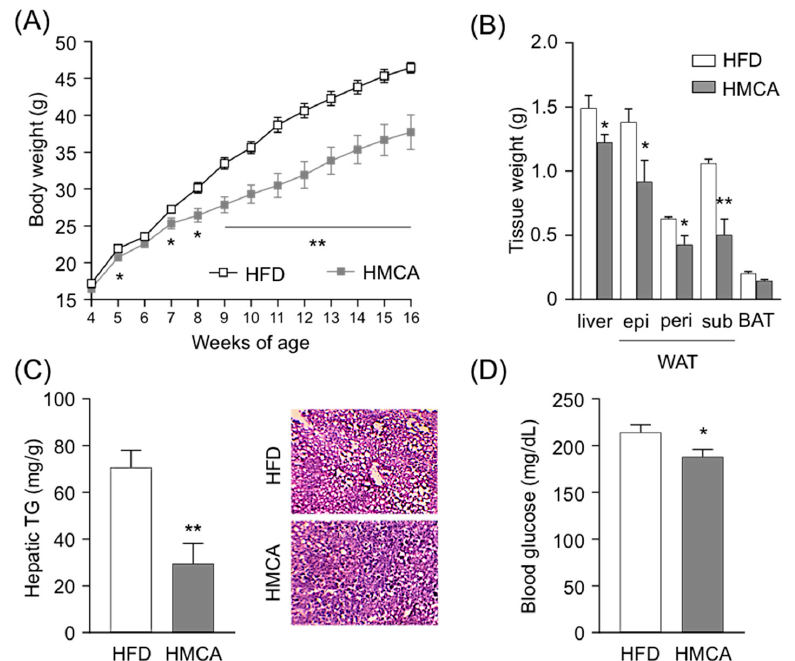
Figure 1. Metabolic parameters and histological changes in high-fat diet (HFD)- and 4-hydroxy-3-methoxycinnamic acid (HMCA)-supplemented HFD-fed mice. Mice were characterized for body weight gain ( A ), the mass of WAT, BAT, and liver ( B ), hepatic TG and histology of hepatocytes by hematoxylin and eosin (H&E) staining ( C ), and blood glucose ( D ) ( n = 7–8). All data are presented as the means ± SEM. Differences were assessed by Student’s t -test. Significance is established at adjusted ** p < 0.01 and * p < 0.05. WAT: white adipose tissue; BAT: brown adipose tissue; TG: triglyceride.